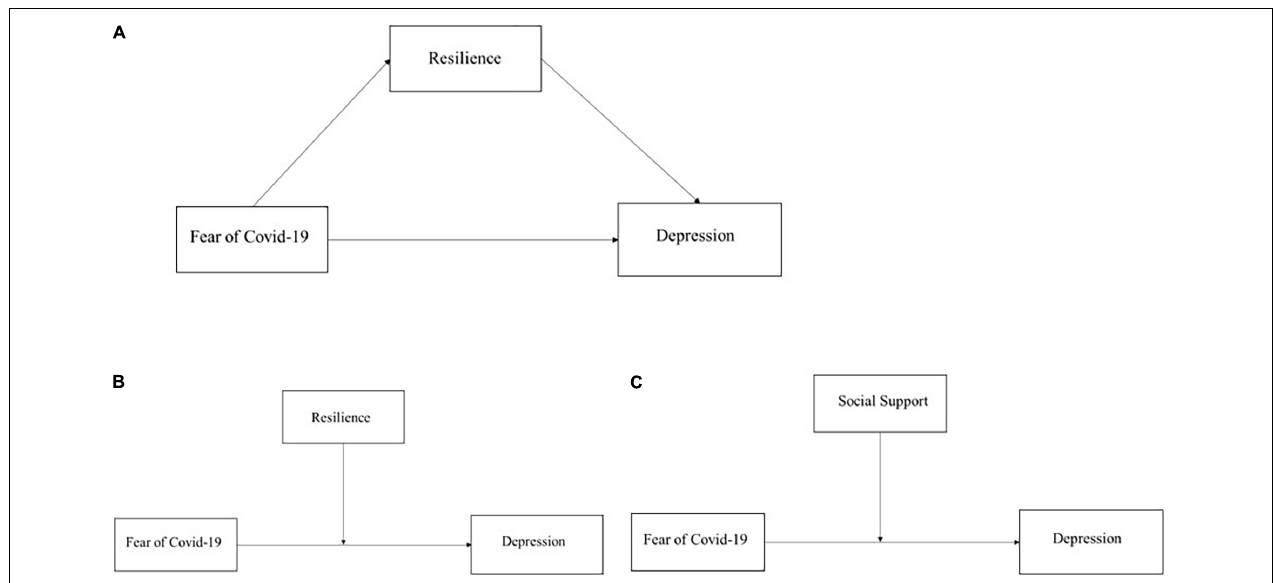
FIGURE 1 | Conceptual models. (A) Conceptual model for testing whether resilience will mediate the association between FoC and depression. (B) Conceptual model for testing whether resilience will moderate the association between FoC and depression. (C) Conceptual model for testing whether social support will moderate the association between FoC and